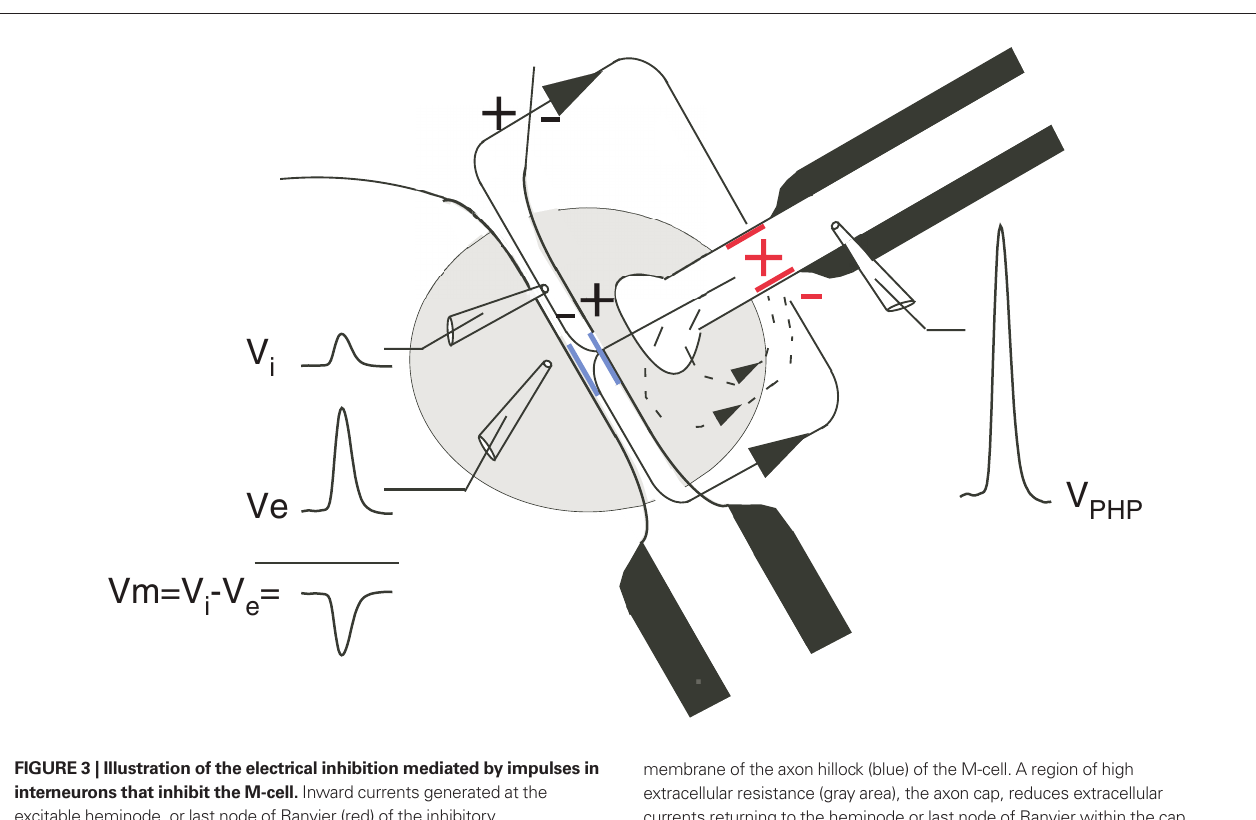
membrane of the axon hillock (blue) of the M-cell. A region of high extracellular resistance (gray area), the axon cap, reduces extracellular currents returning to the heminode or last node of Ranvier within the cap (arrow with dashed line) and directs the current across the